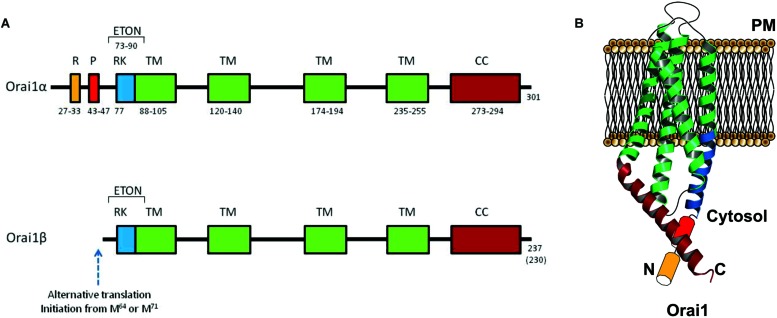
Molecular structure of Orai1α and Orai1β variants. (A) Orai1α and Orai1β architecture. R, arginin-rich region; P, proline-rich region; RK, arginine-lysine-rich region; TM, transmembrane domain; CC, coiled-coil domain (Yuan et al., 2009; Derler et al., 2012). Orai1β has an alternative translation initiation from methionine at position 64 or 71 (Fukushima et al., 2012). (B) Cartoon depicting Orai1α monomer crystal structure in the resting state.